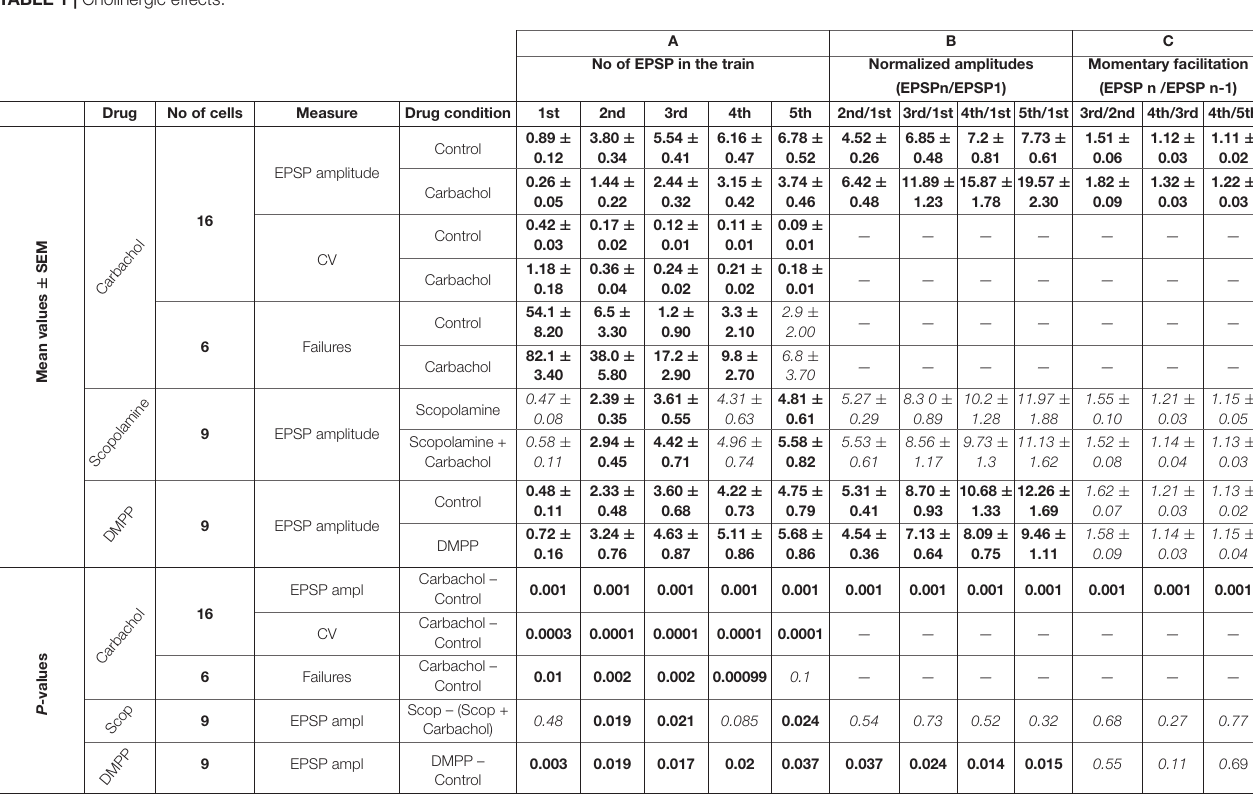
TABLE 1 | Cholinergic